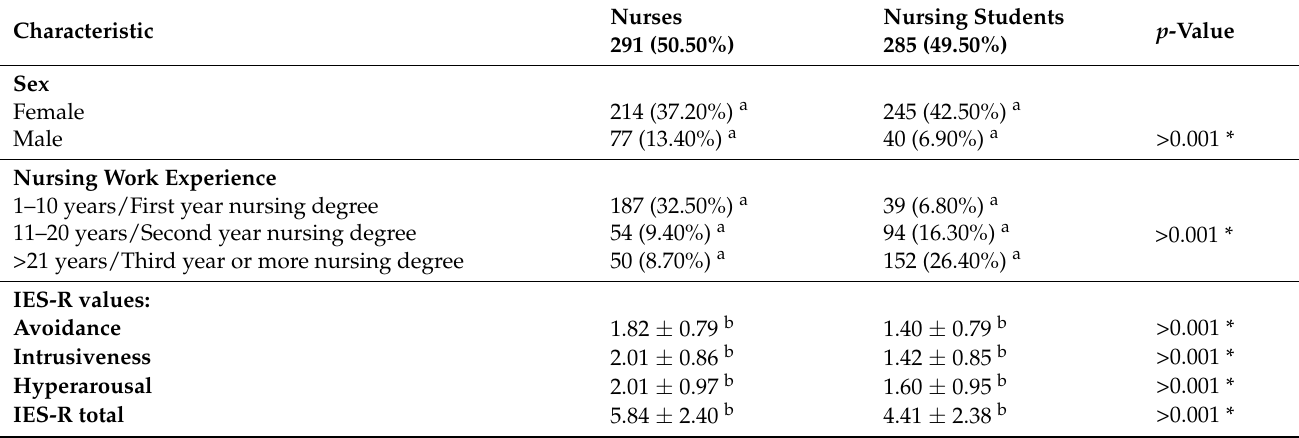
Table 1. Sampling characteristics ( n = 576).